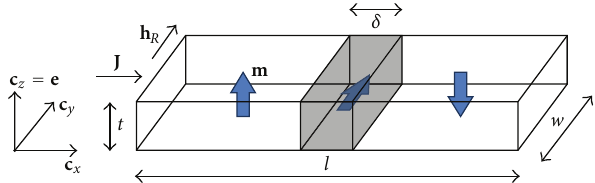
Figure 1: Schematics of a ferromagnetic nanostrip exhibiting a Bloch